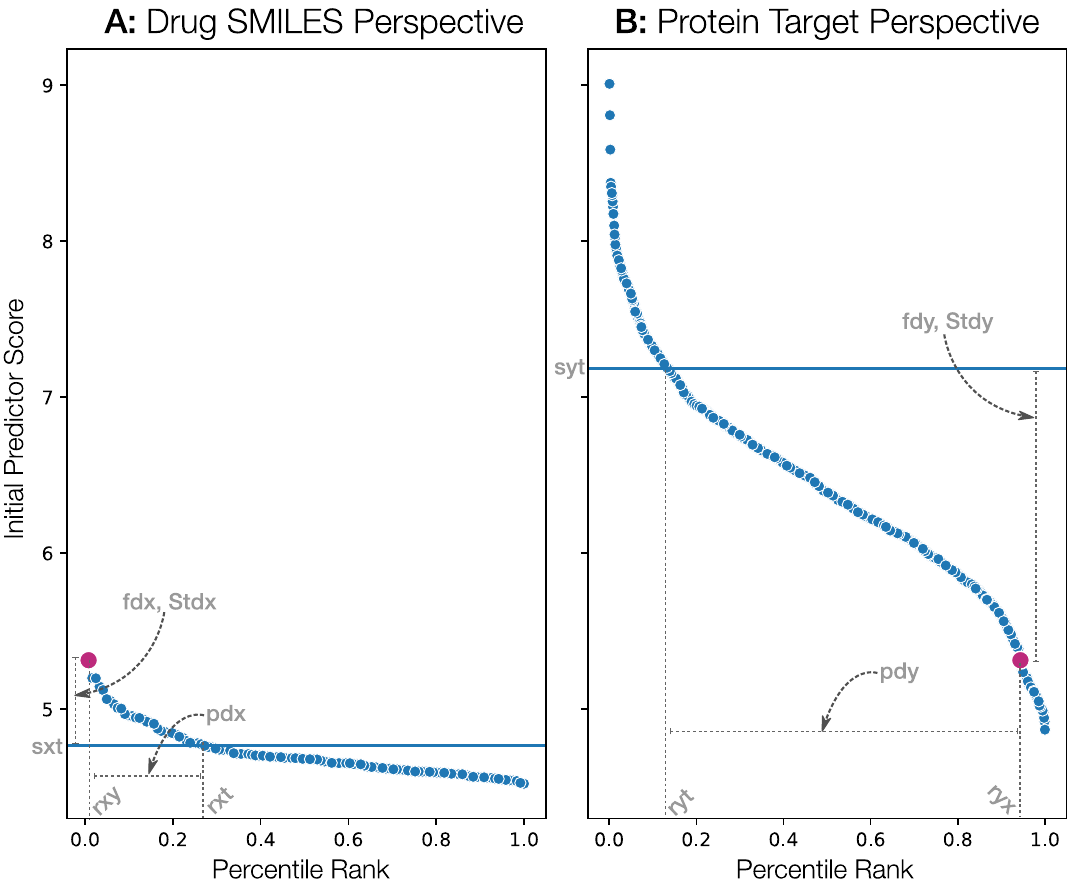
Figure 3. Example paired one-to-all score curves. An example pair demonstrating dramatically differing distributions is depicted to emphasize that even though a given drug scores relatively low in the given protein target perspective, that protein is the top-scoring target for that specific